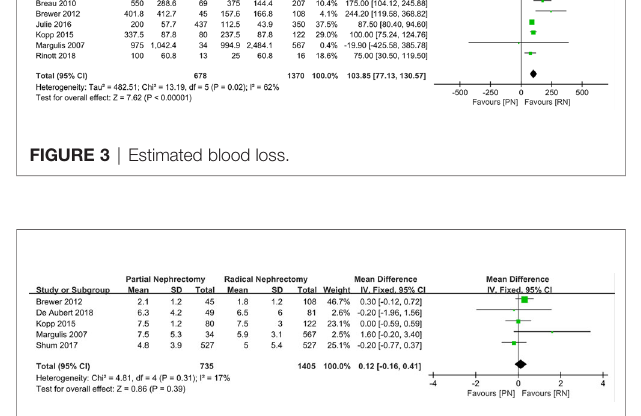
Figure 6 ). The renal function of the patients in both groups